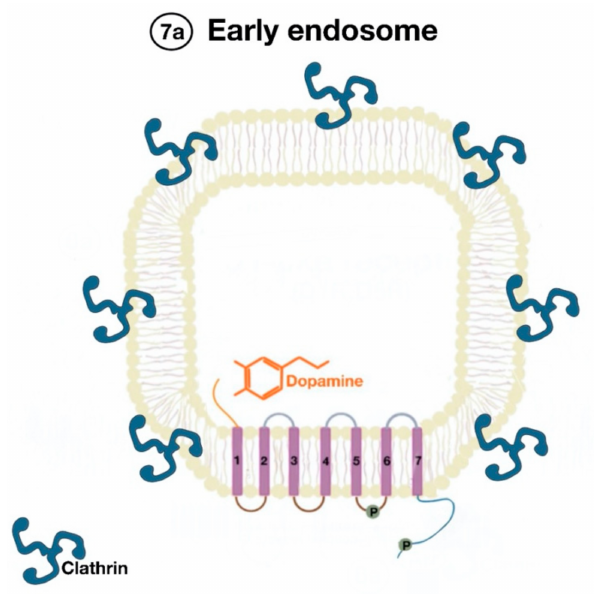
Figure 7. Endocytosed GPCR (dopamine receptor) is packaged in an early endosome (7a).